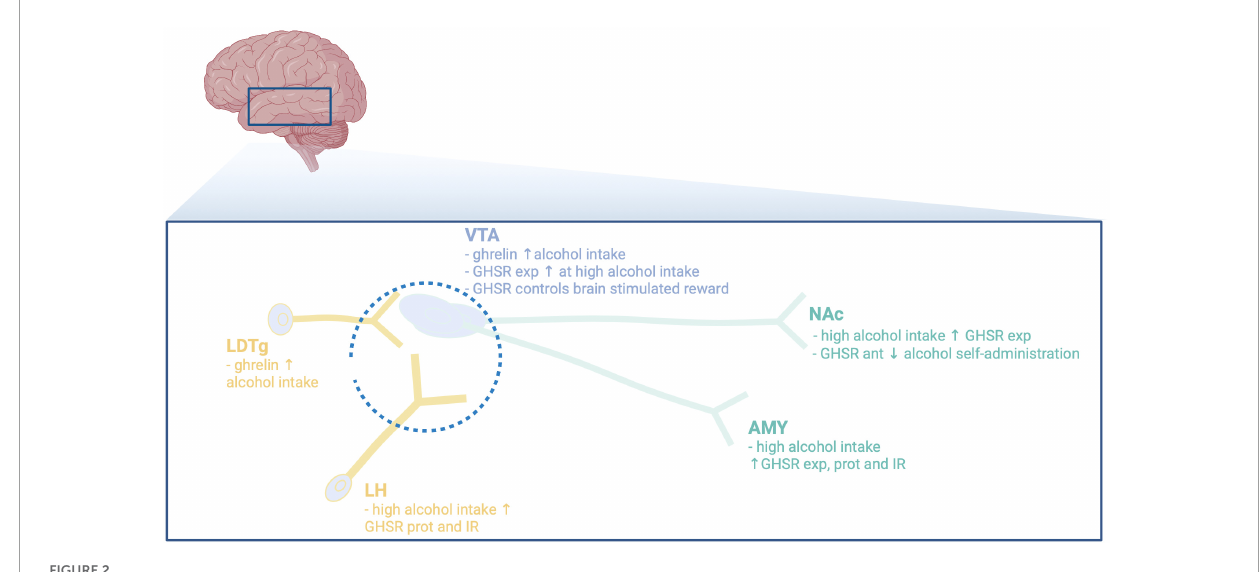
FIGURE2 Illustrative summary of available preclinical studies on the main brain regions participating in the interaction between alcohol and the ghrelin pathway. VTA, ventral tegmental area; NAc, nucleus accumbens; LDTg, laterodorsal tegmental area; LH, lateral hypothalamus; AMY, amygdala; exp, expression; ant, antagonist; prot, protein; IR, immunoreactivity; ↓ , decreases; ↑ , increases. Created with